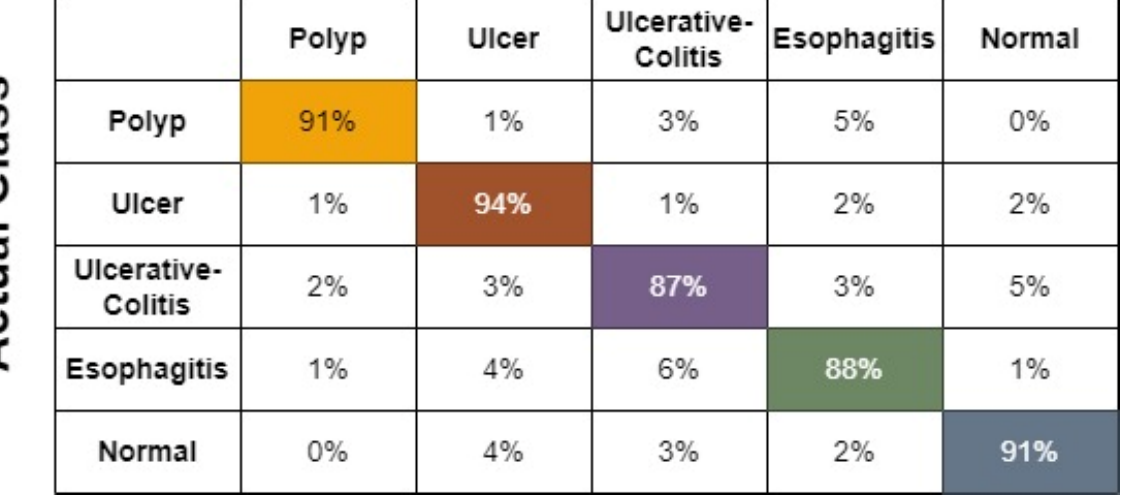
Table 5. Classification performance using contrast - enhanced images after dataset augmentation.